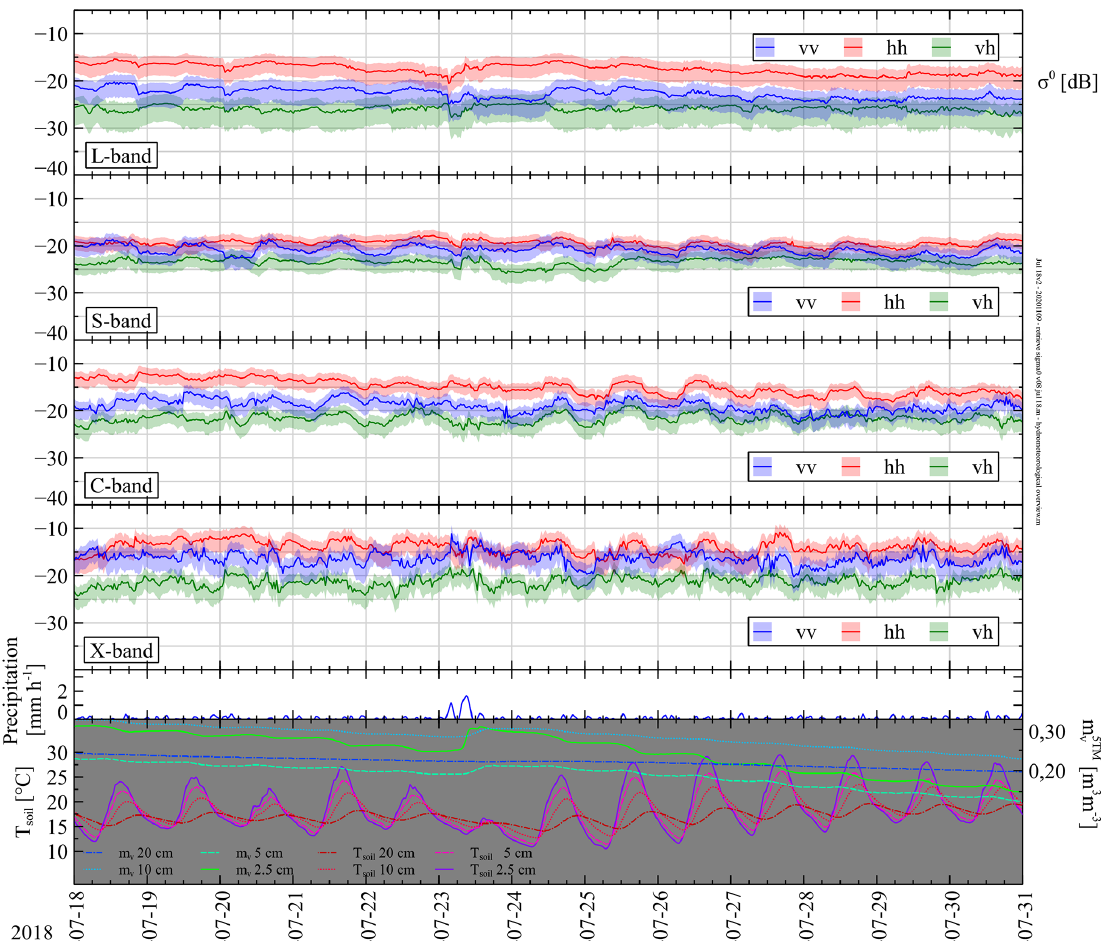
Figure D3. Time-series measurements of σ 0 pq (m 2 m − 2 ) for L-, S-, C-, and X-band, precipitation, M v , and T soil during 13d in July 2018. Same configurations as Fig. D1